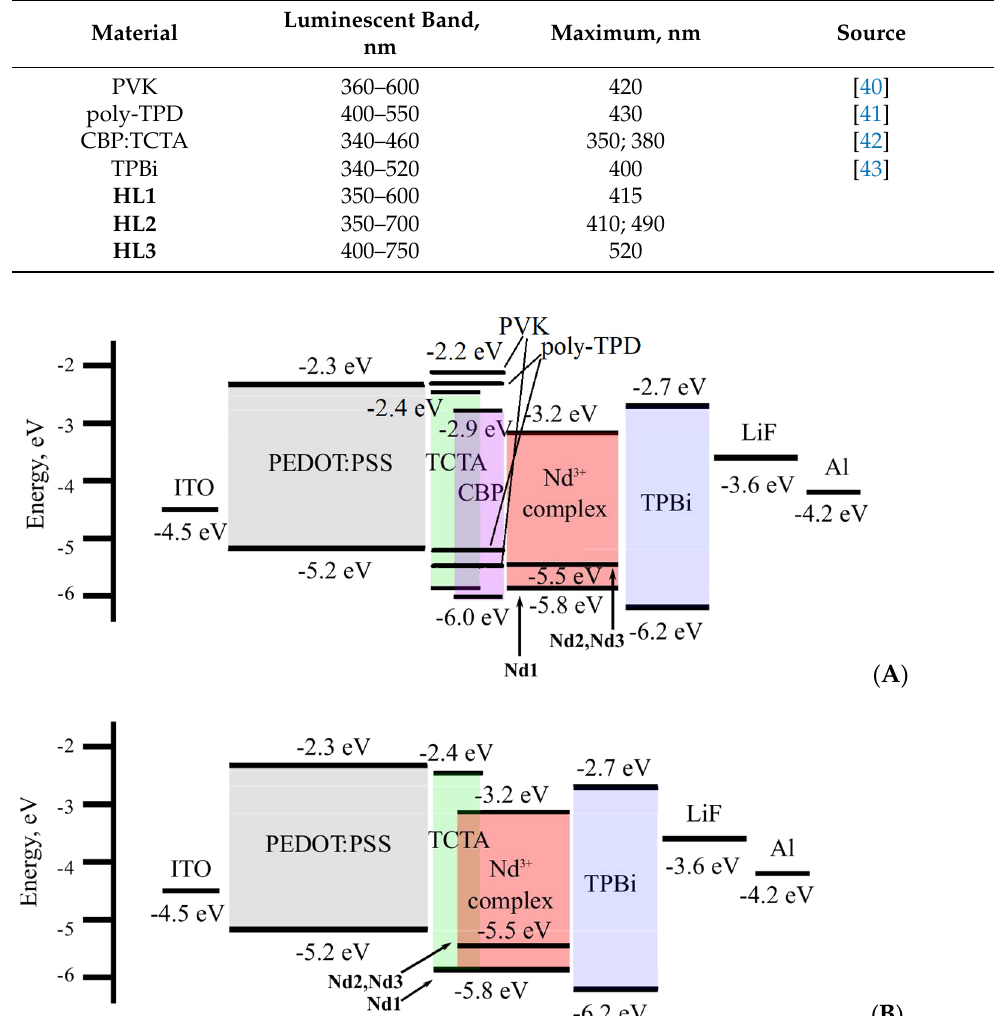
Figure 7. Energy level diagrams of the ( A ) and ( B ) devices with the Nd1 , Nd2, and Nd3 complexes. Table 3. Luminescent properties in visible spectral range for the materials employed in